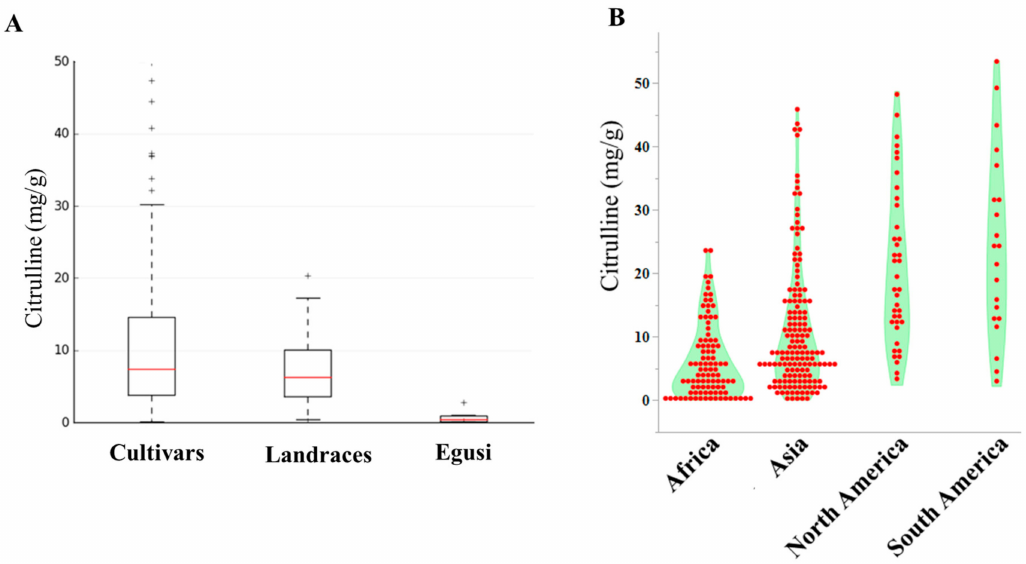
Figure 1. Citrulline content in watermelon accessions. ( A ) Box plots showing the range, mean, and distribution of citrulline content in cultivars, landraces, and egusi types. ( B ) Violin-scaled contour map showing world geographic variation in citrulline content across the